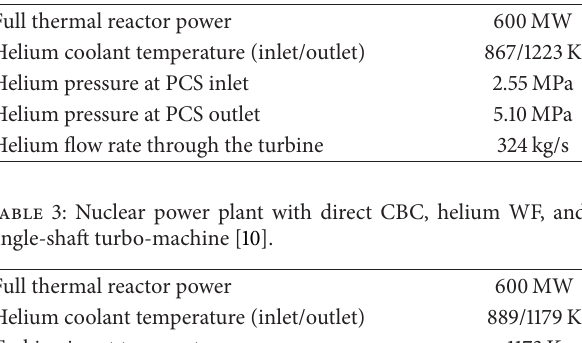
Table 2: Major design parameters of the GT-MHR [8].